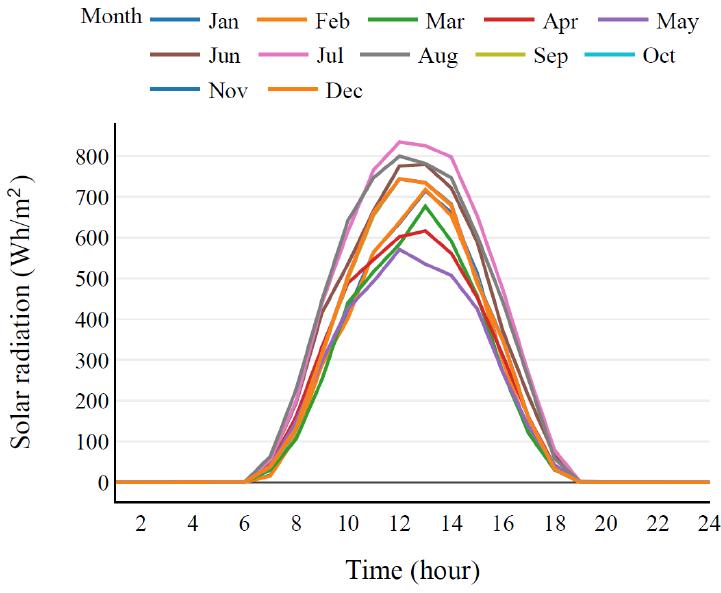
Figure 5. Daily average solar radiation for one year by